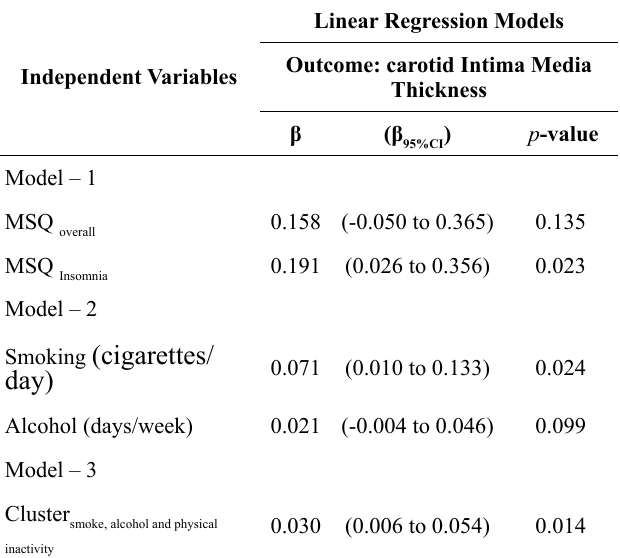
Table 3. Relationship between sleep quality and intima media thick- ness among young